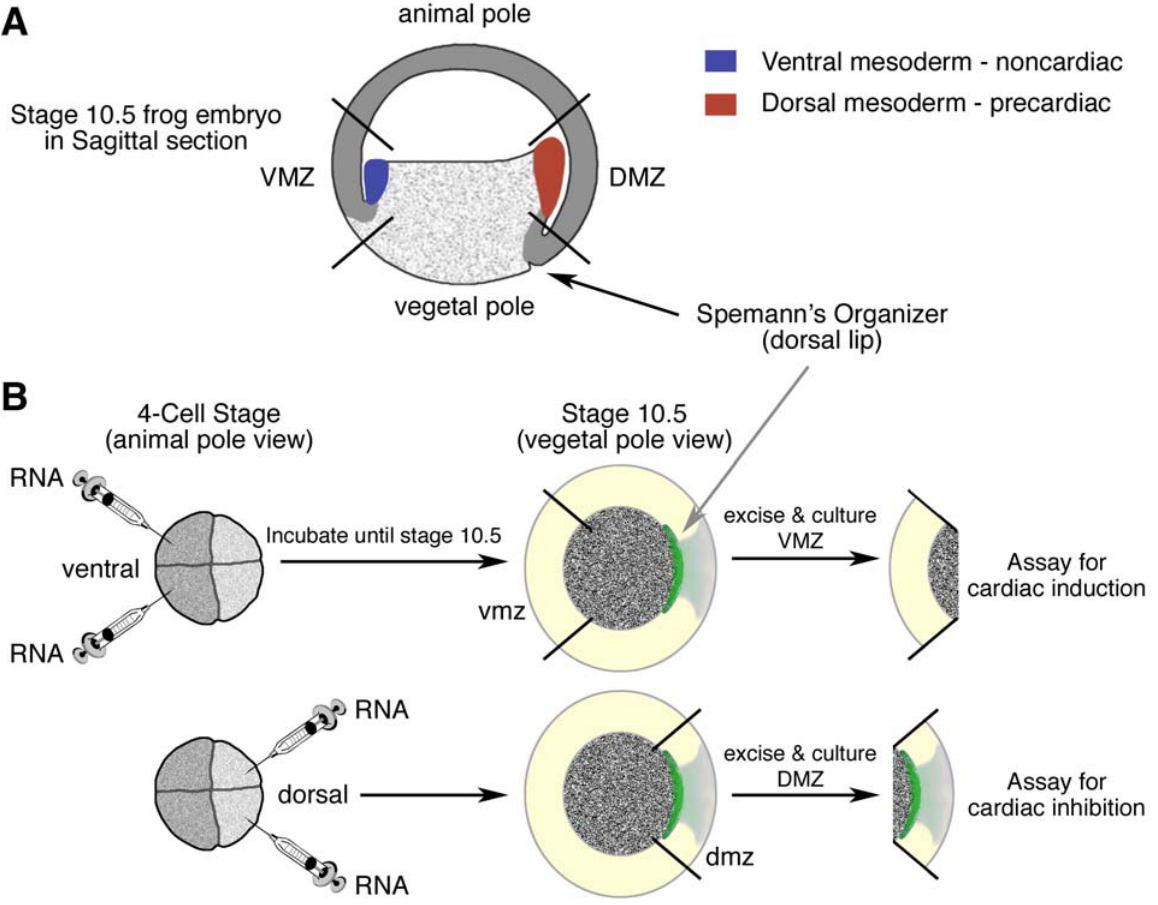
FIGURE 4. Cardiac tissue formation in Xenopus tissue explants. (A) Drawing depicts an early frog gastrula (stage 10.5) in sagittal section. Highlighted are the dorsal mesoderm (red), which contains the bilaterally distributed precardiac tissue fields, and the ventral mesoderm (blue), which does not contribute cells to the heart in situ . (B) Experimental outline used to study the regulation of heart formation in the frog. The functional role of individual genes in heart development is examined by injecting their RNA into either the ventral or dorsal blastomeres at the two- or four-cell stage. After allowing the embryos to develop to stage 10.5, the ventral marginal zone (VMZ) or dorsal marginal zone (DMZ) is excised and incubated in culture. Subsequently, these explants are examined for cardiac gene expression and the formation of a contractile phenotype. Experiments investigating the induction of cardiac tissue formation from VMZ explants or suppression of cardiogenesis in DMZ explants have provided important information on the regulatory events underlying the formation of the frog